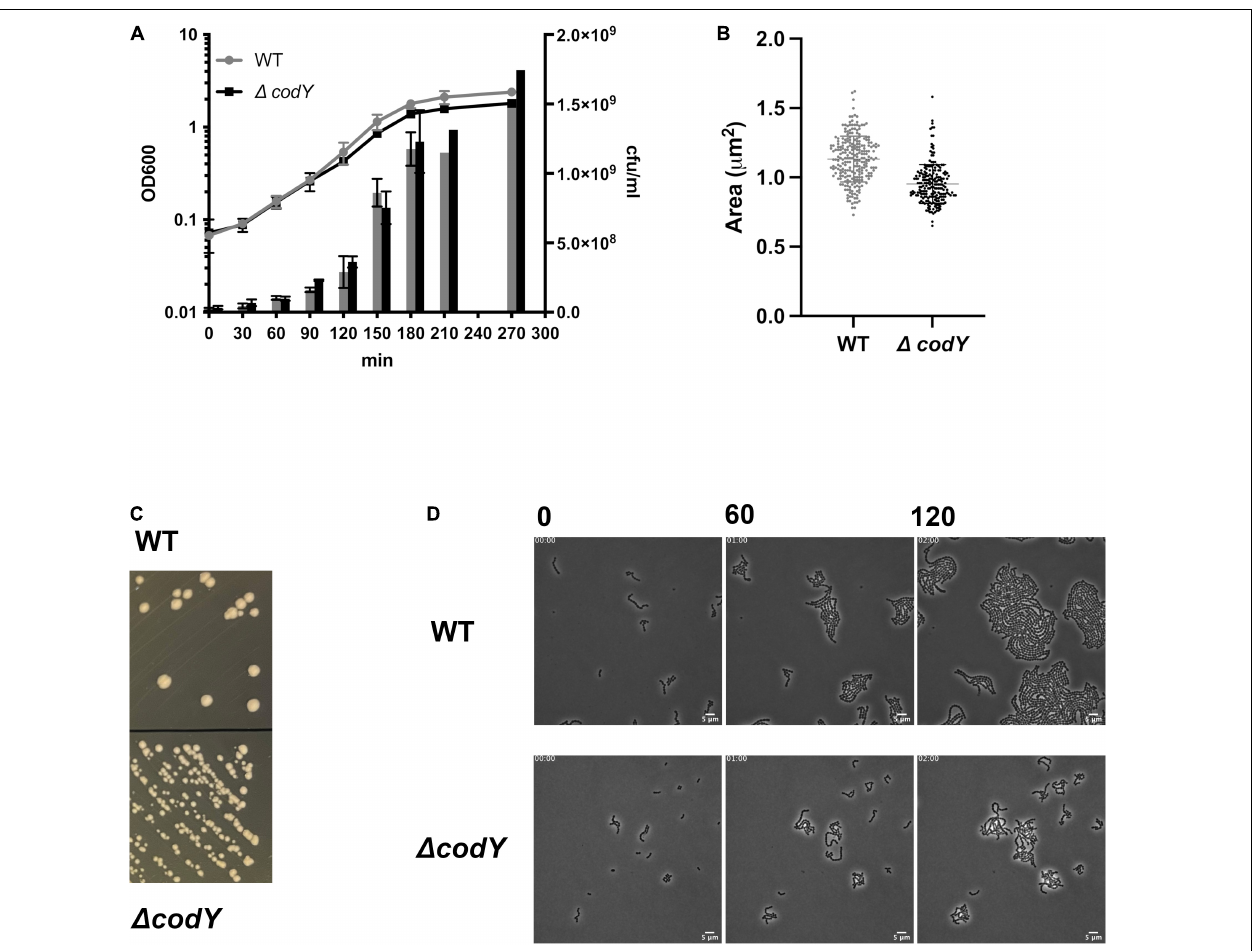
FIGURE 1 | Deletion of codY does not affect cell growth but is associated to a smaller cell size and colony morphology. (A) Growth of the BM110 strain (WT) and of the isogenic codY deletion mutant ( (cid:49) codY ) in THY rich medium, evaluated as absorbance at OD 600 (left axis) and cfu/ml (right axis). Data are the average ± SD of two independent experiments (B) . Single cell area measurements ( µ m 2 ) of 50 cells of each strain. Reported data refer to two independent experiments. Statistically significant differences are indicated (Welch’s t -test). (C) Colonies of the WT and (cid:49) codY strains grown on THY agar plates. (D) Contrast-phase image stacks of BM110 and (cid:49) codY cells during time-lapse microscopy. Scale bar is 5 µ